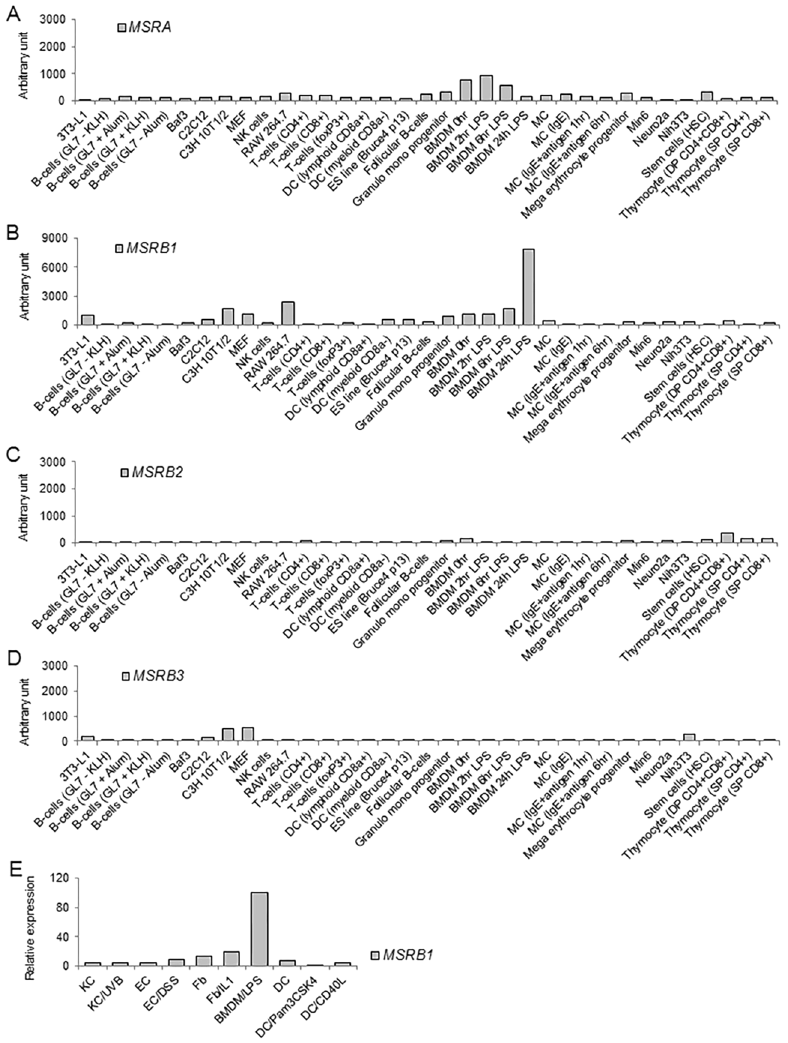
Figure 1. MsrA, MsrB1, MsrB2, and MsrB3 mRNA expression analysis in various mouse primary cell types and cell lines. ( A – D ) Comparison of relative amounts of mRNA encoding mouse MsrB1 ( A ), MsrA ( B ), MsrB2 ( C ), and MsrB3 ( D ) in the cell types and cell lines annotated in the BioGPS database (http://biogps. org/#goto = welcome). ( E ) Relative amounts of mouse MsrB1 mRNA in keratinocytes (KC) with or without ultraviolet-B irradiation (UVB; 75 mJ/cm 2 ), enpithelial cells (EC) from intestines with or without dextran sulfate sodium (DSS, 3.5%) exposure, fibroblasts (Fb) with or without IL-1 (20 ng/ml) stimulation, bone marrow-derived macrophages (BMDM) with LPS (100 ng/ml) stimulation, and dendritic cells (DC) with or without Pam 3 CSK 4 (1 μ g/mL) or CD40L (1 μ g/mL) stimulation. Data are representative of two independent